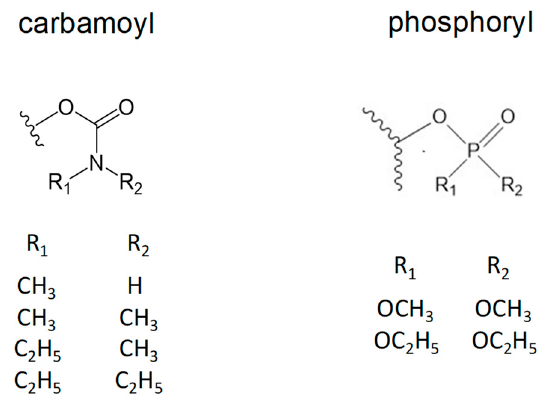
Figure 1. Molecular structures of carbamoyl and phosphoryl groups attached to human acetylcholinesterase (AChE; squiggled line) compared in this report. Alkyl groups R 1 and R 2 are